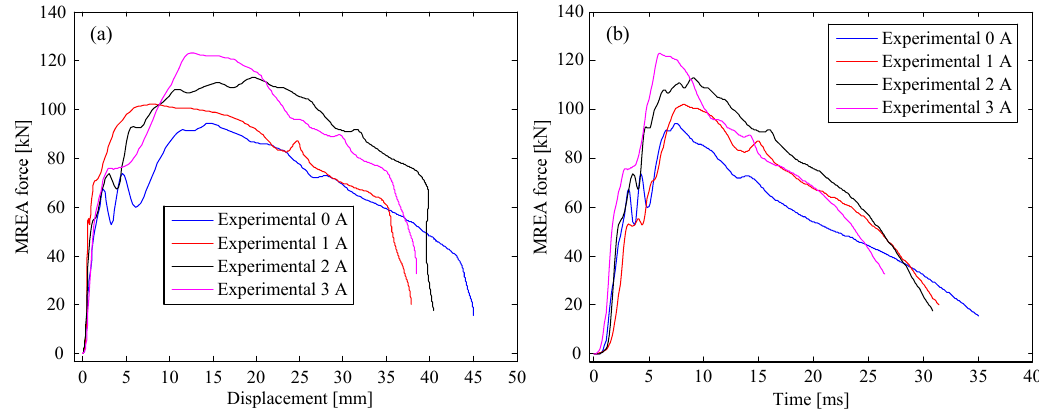
Figure 3. MREA performances at a drop height of 0.4 m: ( a ) force vs. displacement and ( b ) time history of the force.